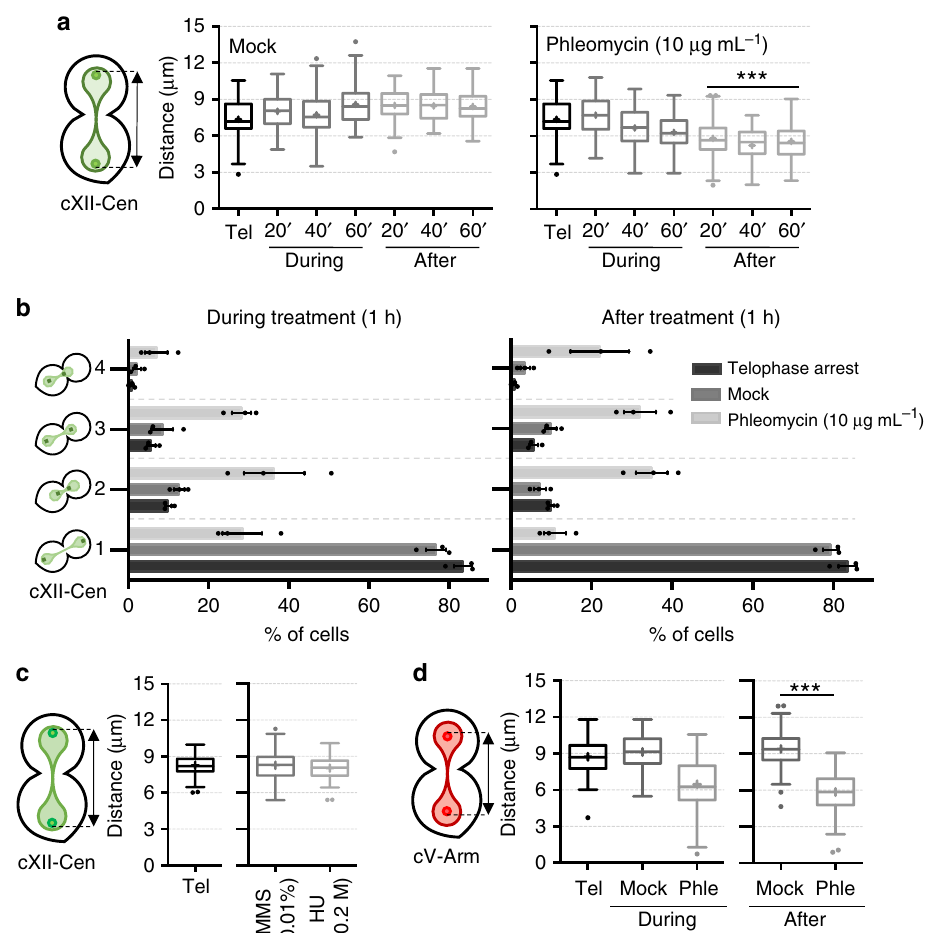
Fig. 2 DNA double-strand breaks in telophase lead to sister loci approximation. a Sister centromeres approach each other during and after generating DSBs in telophase. FM593 was treated as in Fig. 1d, except for the fact that the telophase block was maintained (37 °C) even after phleomycin was washed away. Samples were taken every 20 ′ during and after phleomycin (or mock) treatment and visualised under the microscope. Distance between sister cXII centromeres was measured and box-plotted for each time point ( N = 70 cells per box; *** indicates p < 0.0001 in mock/phleomycin comparisons at each time point, Mann-Whitney U Test). b Relative position of cXII sister centromeres from the former experiment was categorised as depicted on the left (mean ± s.e.m., n = 3 independent experiments); category 1, both centromeres at near polar locations; category 2, closer centromeres with symmetrical distances to the bud neck; category 3, closer centromeres with asymmetrical distances to the bud neck; category 4, one sister centromere at the bud neck. c DNA damage caused by MMS (0.01 % v/v) or HU (0.2 M) do not trigger approximation of sister cXII centromeres in telophase. FM593 was treated as in ( a ) except for the drug, and the distance between sister cXII centromeres was box-plotted. Only the telophase block and 1 h following drug addition (during treatment) are represented. d Sister loci in the middle of chromosome V also get closer during and after phleomycin treatment. FM2456 was treated like in ( a ) and the distance between sister cXII centromeres was box-plotted (*** indicates p < 0.0001; Mann-Whitney U Test). Source data are provided as